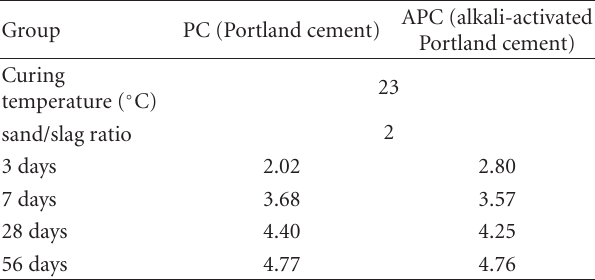
Table 3: Tensile strength of Portland cement mortars at wa- ter/cement ratio of 0.54